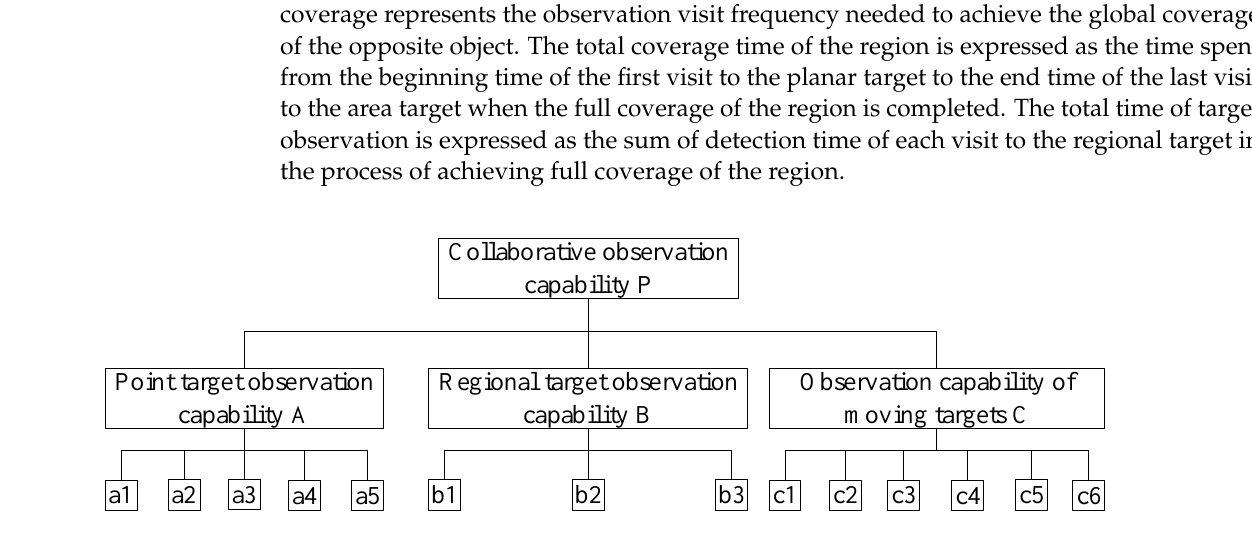
Figure 1. Remote sensing observation capability evaluation index system. Table 1. The description of the label in the Figure 1.